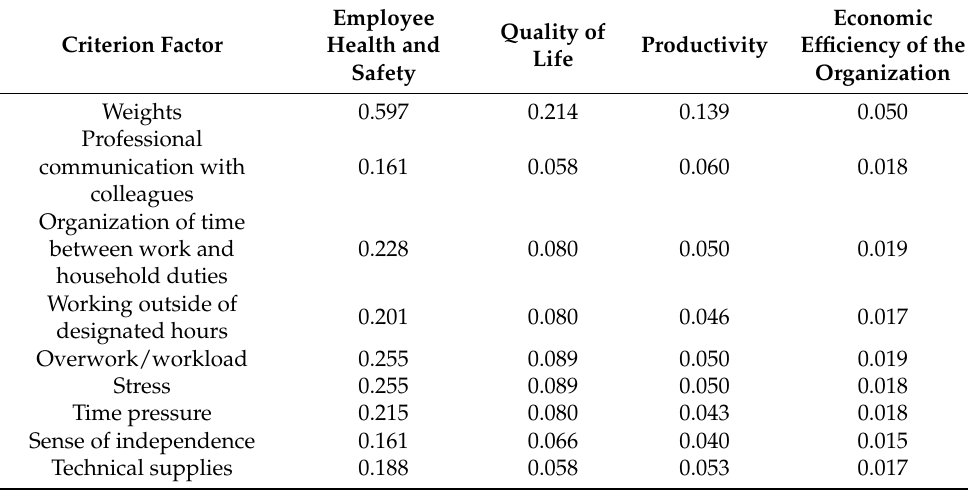
Table 8. Determination of the ideal and anti-ideal